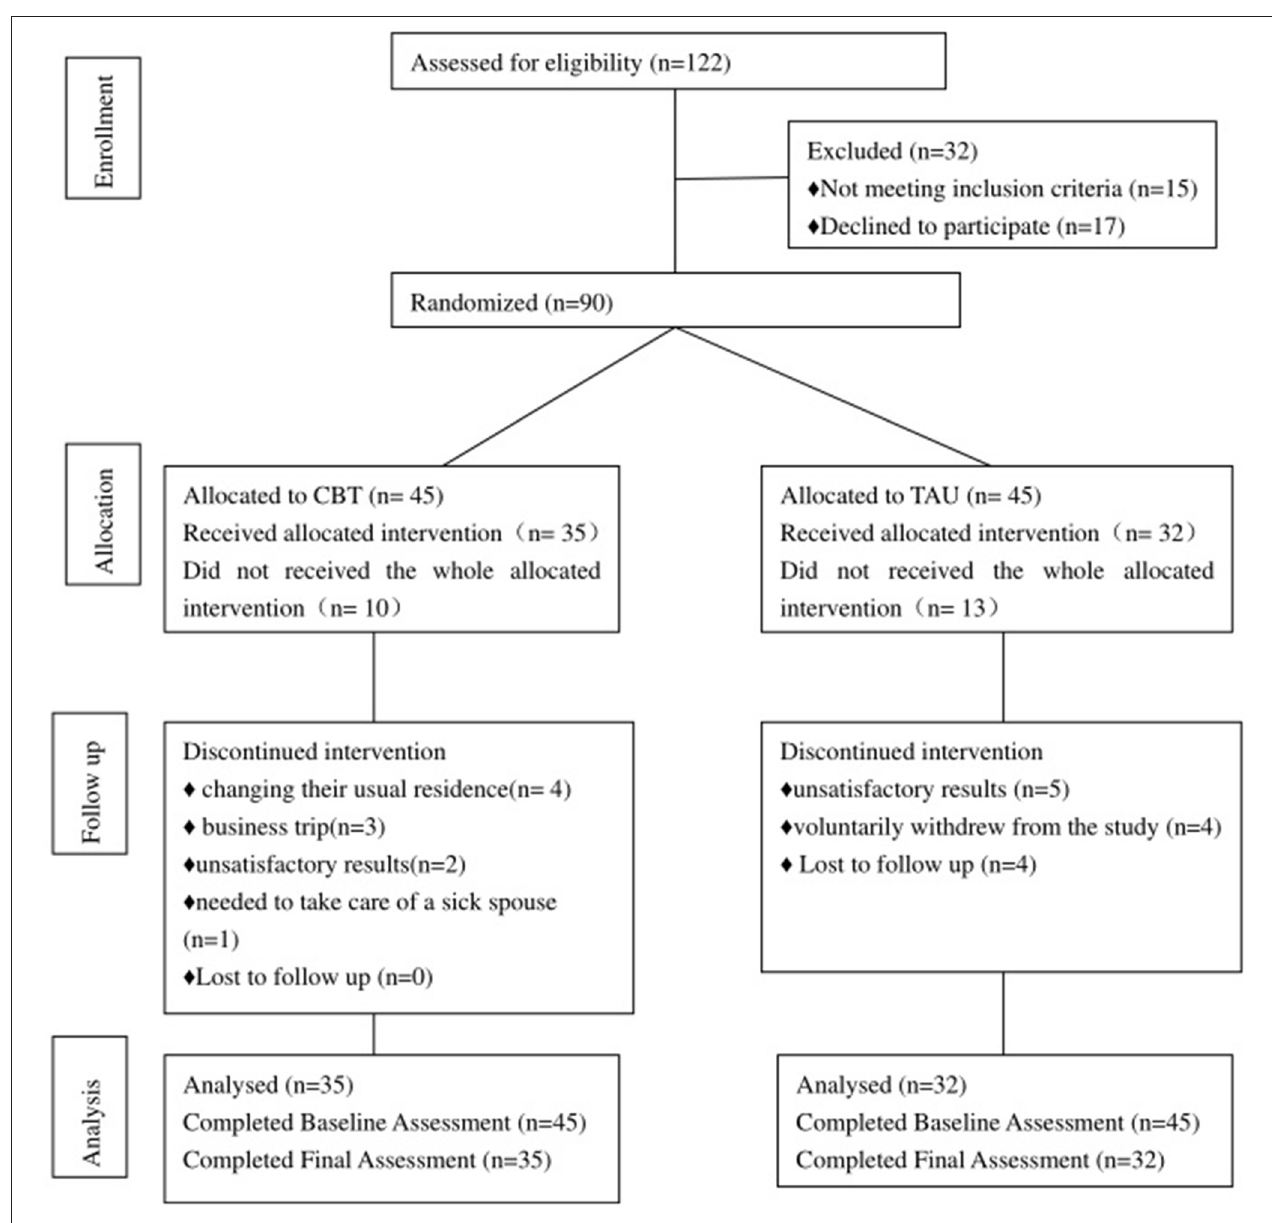
FIGURE 1 | Consort flow